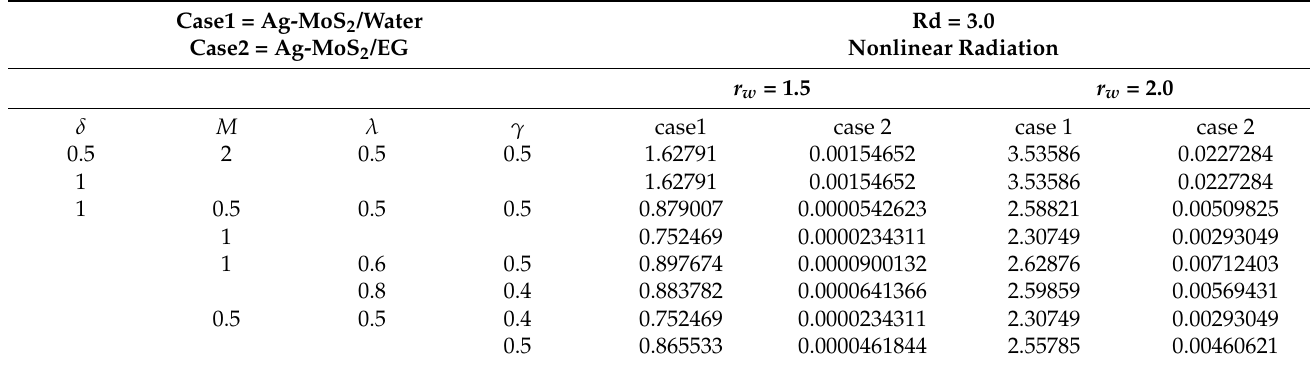
Table 3. The comparison of the Nusselt number (N u x ) results for the Ag-MoS 2 /H 2 O, Ag-MoS 2 /EG hybrid nanofluids.